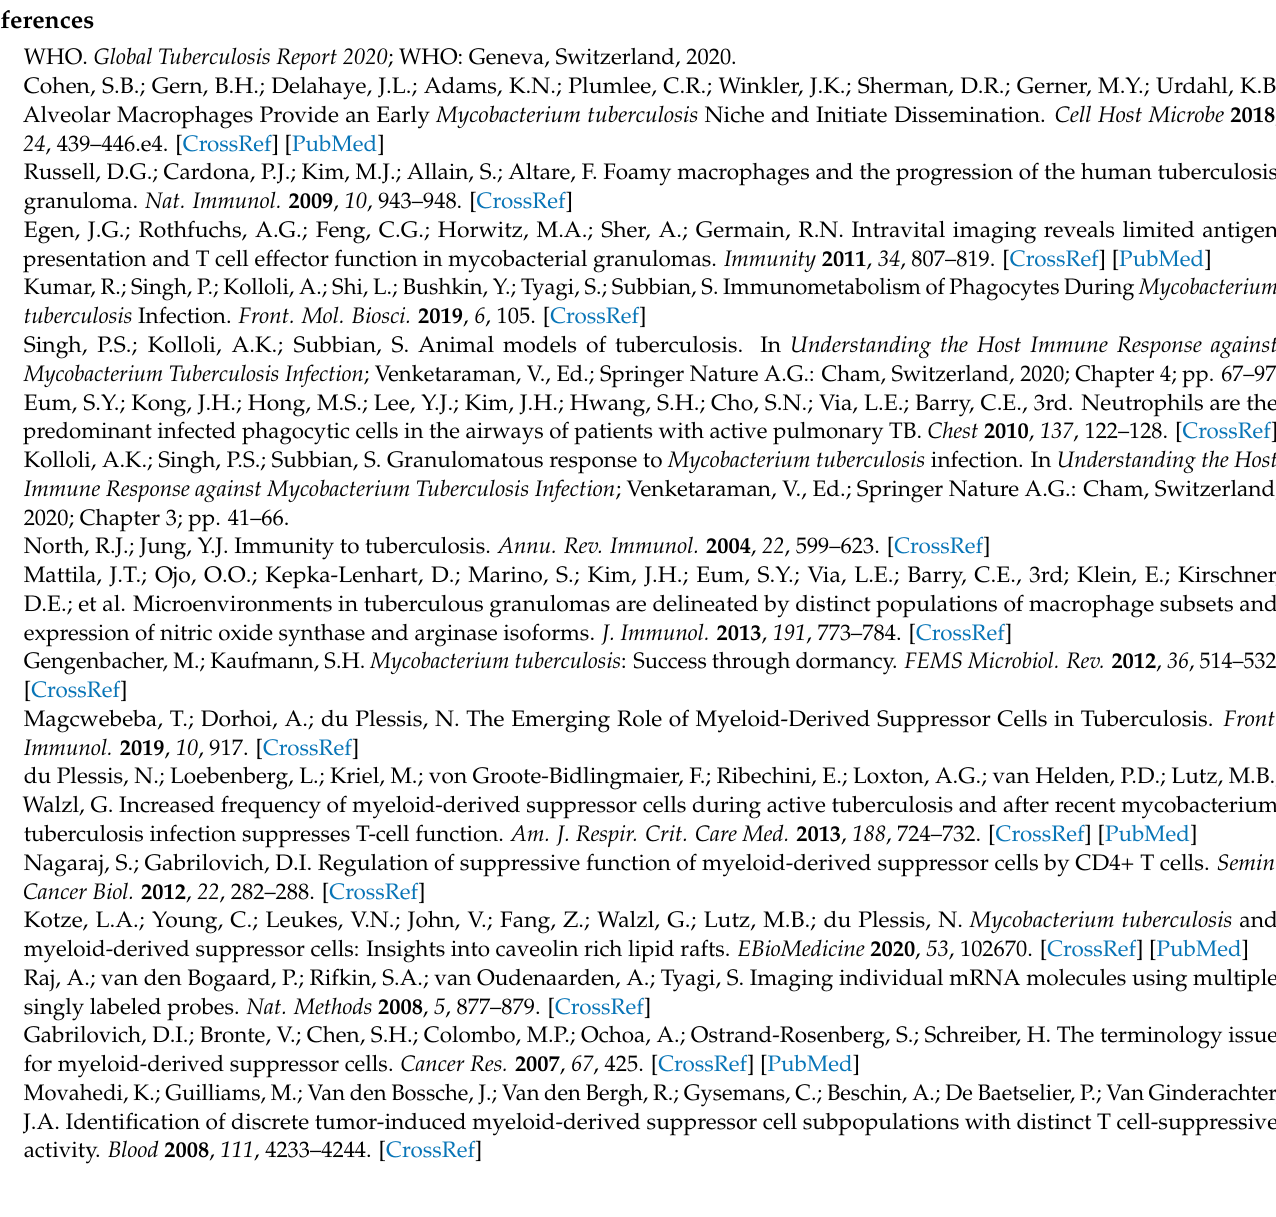
Figure S1: Representative images of H&E stained lung sections of patients with lung TB; Figure S2: Proportion of various host immune cells expressing cell surface and effector molecules in the individ- ual samples of control and solid or necrotic